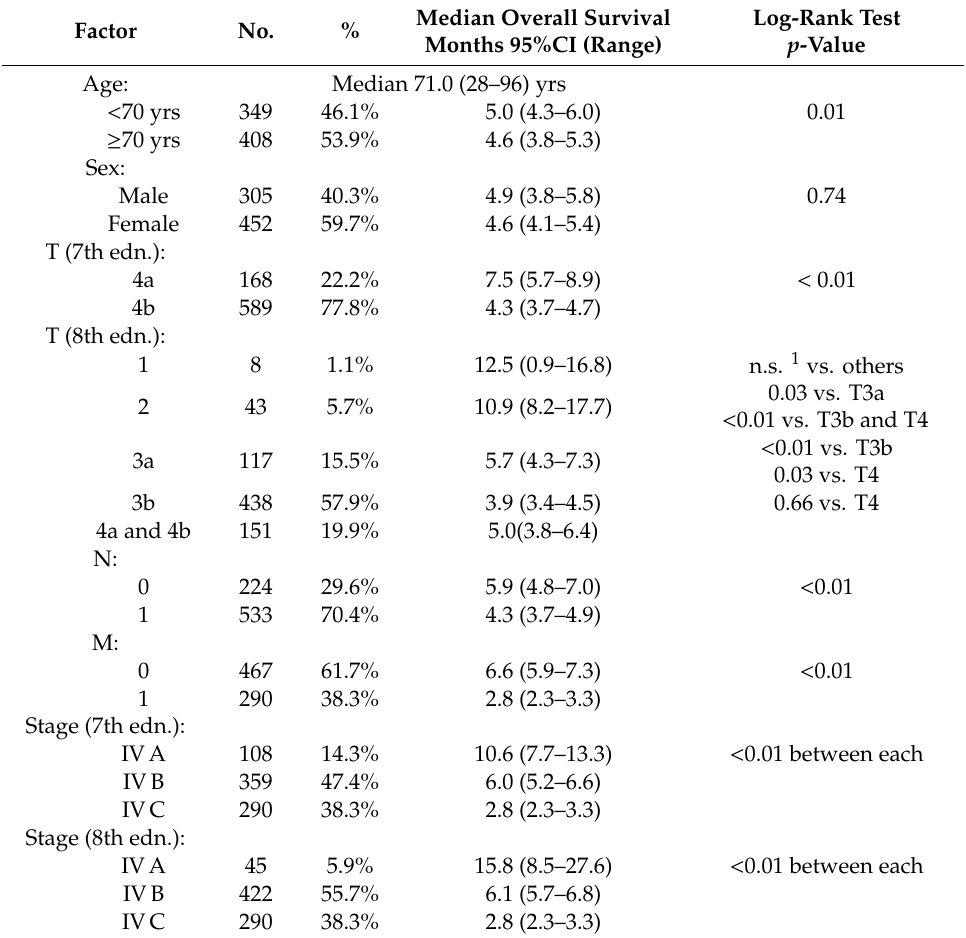
Table 2. Distribution and overall survival of the ATC patients according to the clinical factors and AJCC / UICC TMN